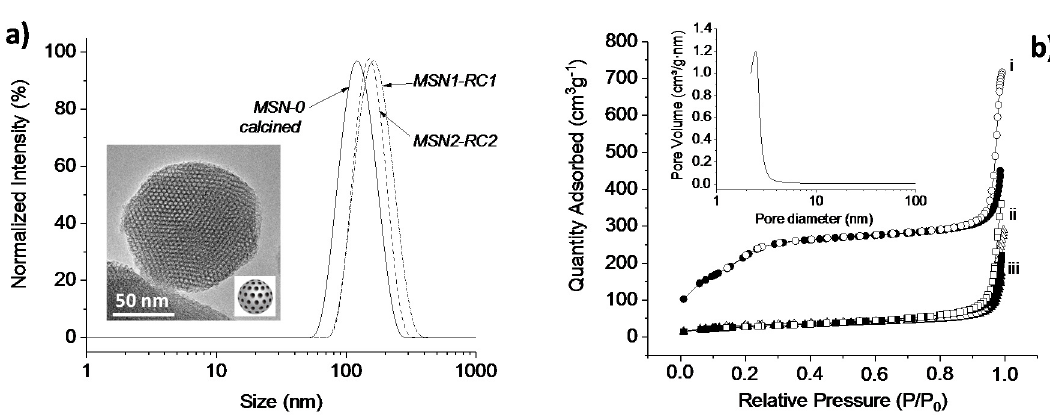
Figure 4. ( a ) Dynamic light scattering (DLS) measurements (hydrodynamic diameter, H D , via normalized intensity, collected data in Table 1) of MSN-0, and MSN1-RC1 and MSN2-RC2